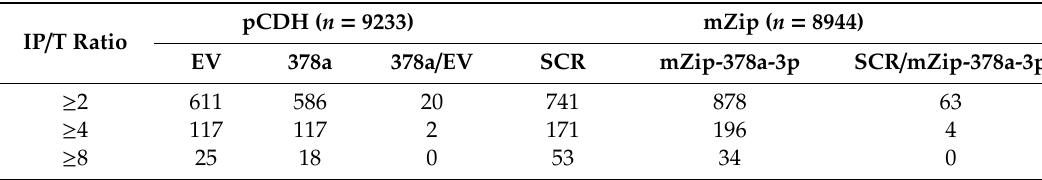
Table 1. Number of genes in the miRNA targetome upon miR-378a-3p overexpression (pCDH) and inhibition